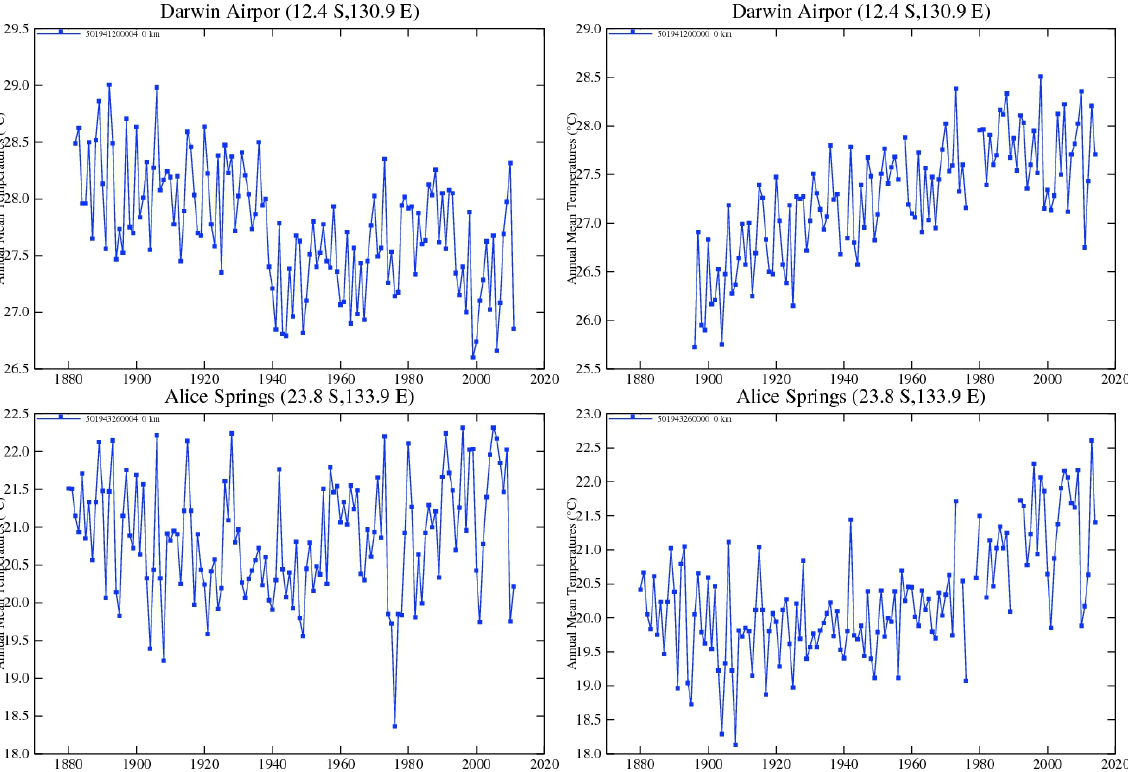
Fig. A.2: GISS v2 vs. v3 temperature records for Darwin and Alice Springs, Northern Territory, Wilson Promontory, Cape Otway and Ballarat, Victoria, Adelaide Airport, South Australia, Eucla, Western Australia, Yamba, New South Wales, Brisbane/Eagle Farm, Queensland, Carnar- von, Western Australia, Port Headland, Western Australia and Willis Island, an external territory of Australia. GISS v2 data on the left, GISS v3 data on the